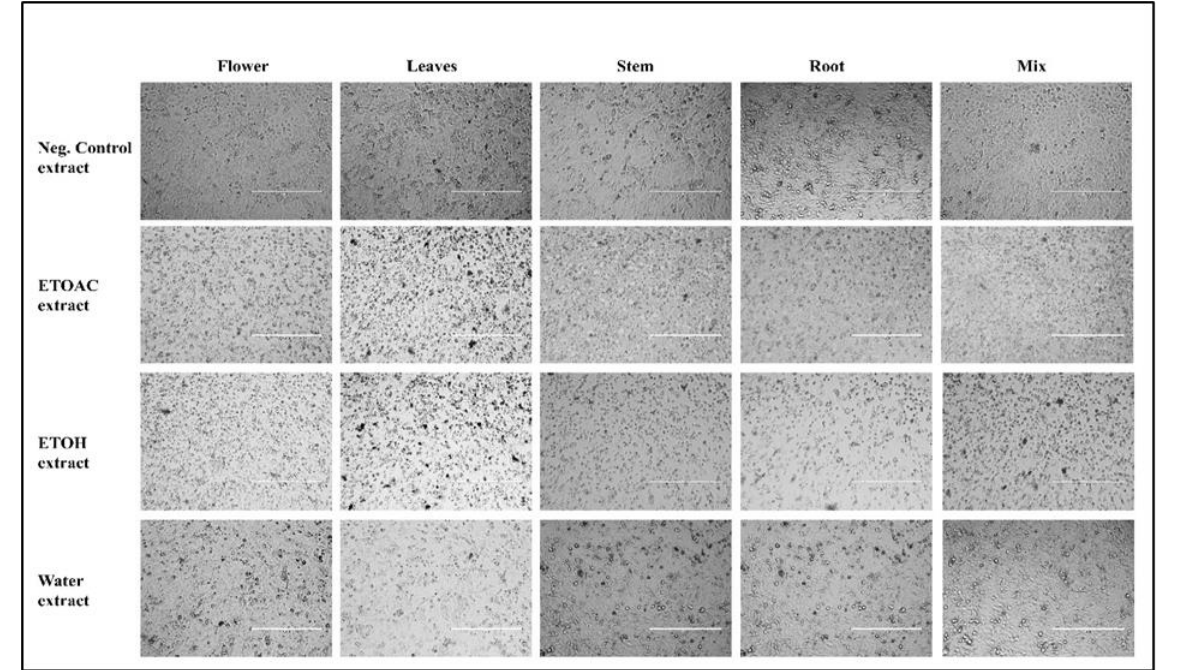
Figure 4. A549 cell photos were captured using a digital camera under an inverted contrast phase microscope, following treatment with the extracts.